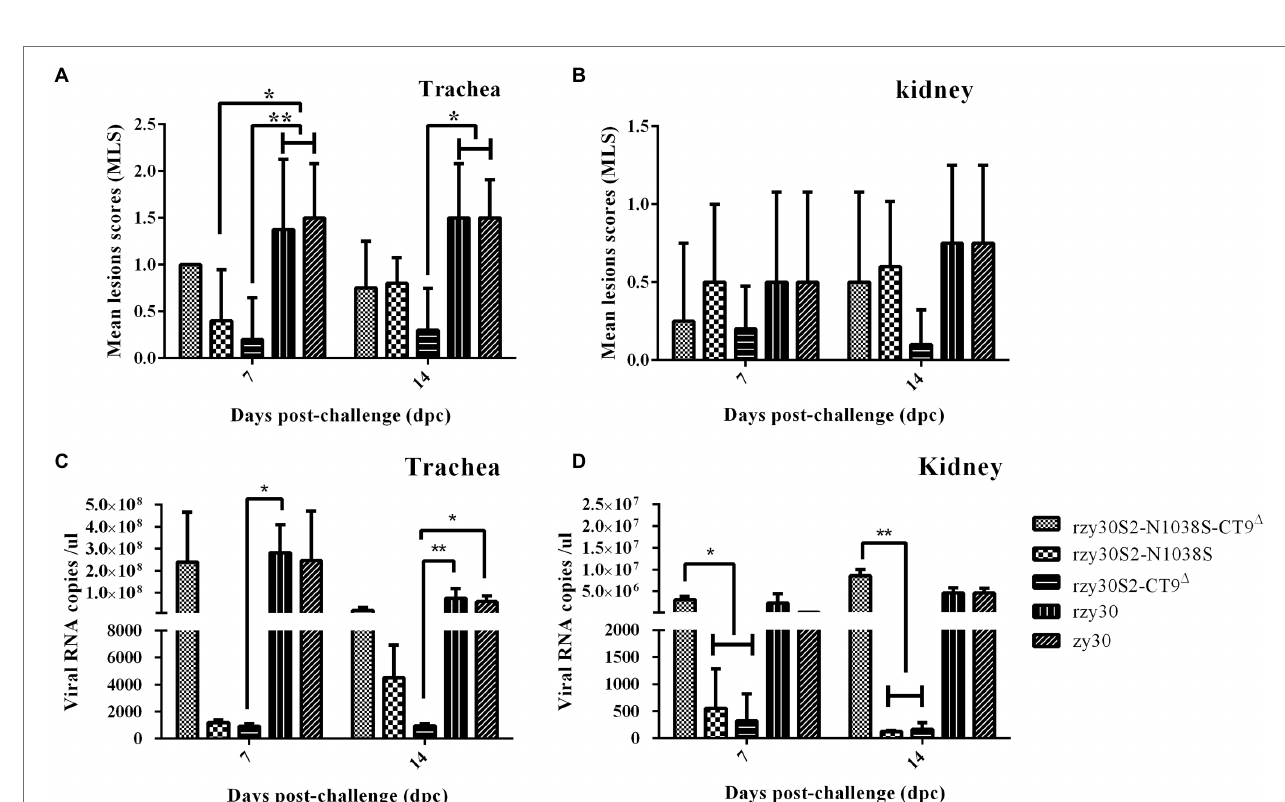
FIGURE 5 | Pathogenicity results of rzy30S2-N1038S-CT9 △ , rzy30S2-N1038S, rzy30S2-CT9 △ , rzy30, and zy30 strains in SPF chickens. The MLS of trachea (A) and kidney (B) from chickens infected with IBV strains. The viral RNA copies of trachea (C) and kidney (D) from chickens infected with IBV strains. Statistical differences between different groups were determined by using the Bonferroni test in ANOVA method for the analysis of MLS of trachea (A) and kidney (B) , and the all pairwise in Kruskal-Wallis one-way ANOVA method for the analysis of the viral RNA copies of trachea (C) and kidney (D) . *Significant difference between the analyzed group with other groups ( p < 0.05) and ** p <